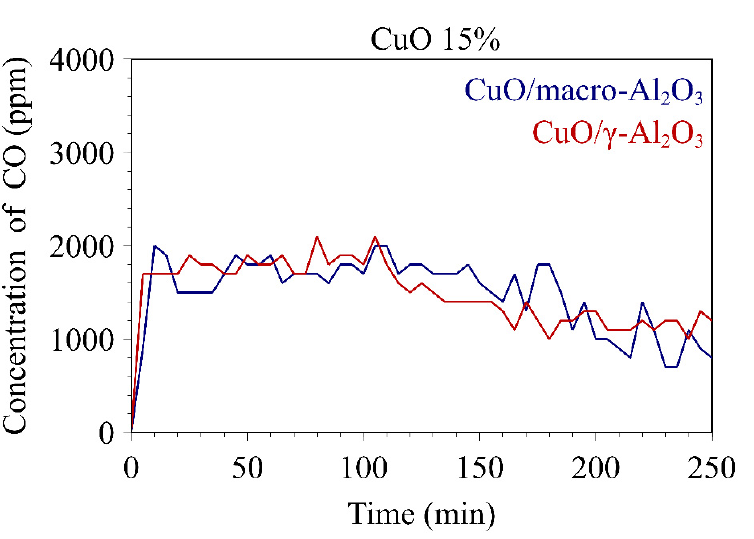
Figure 10. CO concentration vs. time by desulfurization tests over pellet type of 15 wt % CuO-based desulfurization sorbents: CuO/ γ -Al 2 O 3 and CuO/macro-porous Al 2 O 3